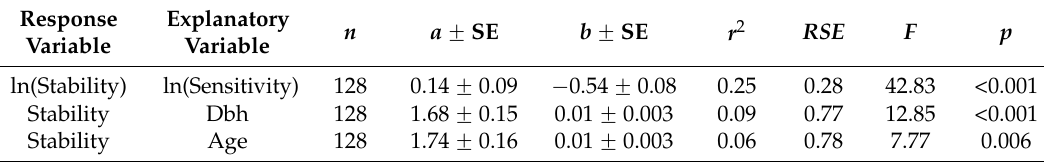
Table 2. Results of linear regressions with stability as response variable and the variables sensitivity, dbh, and age as individually tested explanatory variables for the stability of growth of Tilia cordata and Robinia pseudoacacia in München and Würzburg (equation: response variable = a + b × explanatory variable). The table lists the regression coefficients ( a , b ), coefficients of determination ( r 2 ), RSE for bias